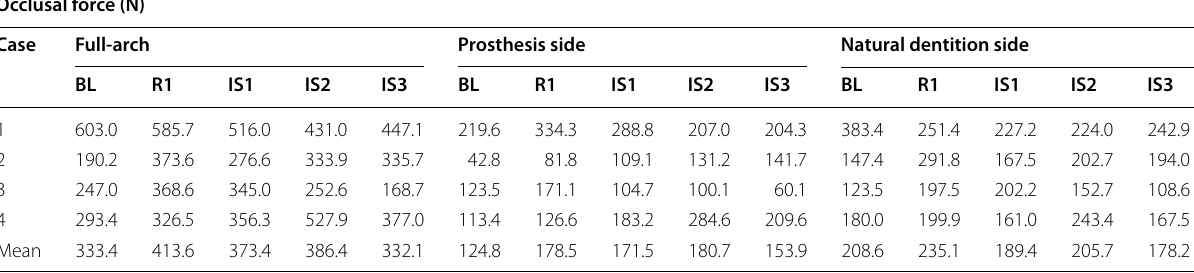
BL baseline, R1 3 months after insertion of removable partial denture (RPD), IS1 3 months after insertion of implant-supported RPD, IS2 6 months after insertion of implant-supported RPD, IS3 12 months after insertion of implant-supported RPD Table 4 Variation in occlusal force of each patient Occlusal force (N)